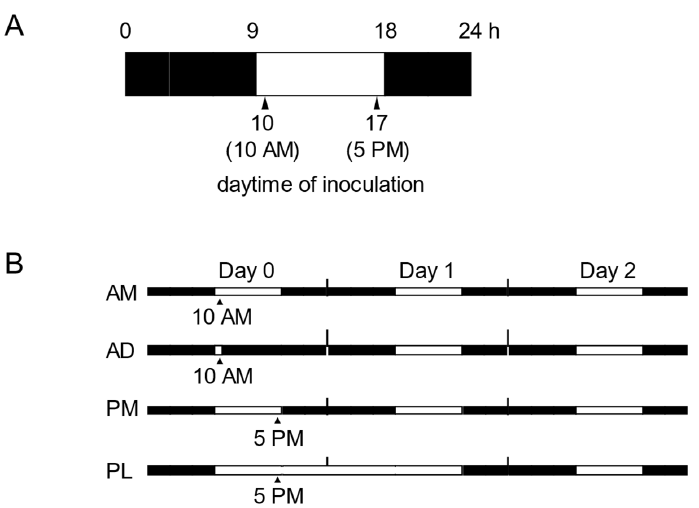
Figure 1. Time scheme used in this study. ( A ) Illustration of daytimes of P. oryzae inoculation. Arabidopsis plants were inoculated at 10:00 a.m. and 5:00 p.m. ( B ) Illustration of light–dark conditions and inoculation times during the experiments. The illustration depicts light regime and inoculation times until day 2. Inoculation was done on day 0, and leaves were harvested on day 3. AM: Arabidopsis plants inoculated at 10:00 a.m.; AD: Arabidopsis plants inoculated at 10:00 a.m. and transferred to continuous darkness until entering the light period in the growth chamber; PM: Arabidopsis plants inoculated at 5:00 p.m.; PL: Arabidopsis plants inoculated at 5:00 p.m. and transferred to continuous lightness until entering the dark period in the growth chamber. White and black boxes correspond to light and dark periods, respectively. Arrowheads and bottom numbers indicate the inoculation times.